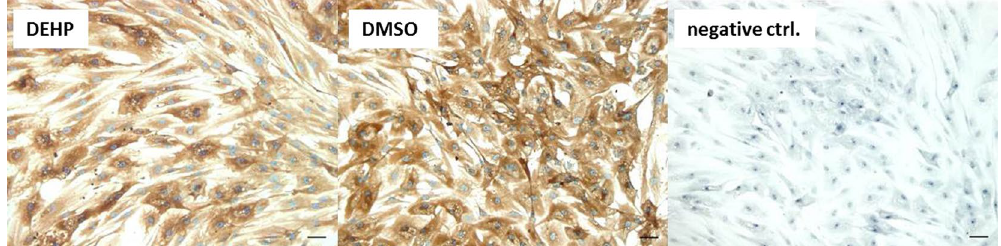
Figure 10. Immunohistochemistry for GLUT4 in SGBS-adipocytes: SGBS cells were exposed to DEHP from d0–d4 and subsequently differentiated into adipocytes. For the analysis of GLUT4 localization within the adipocytes, the cells have been fixed with PFA at d8, stained for GLUT4 (HRP-conjugated antibody – brown staining) and counterstained with hematoxylin (blue staining). The figure shows representative micrographs at × 200 magnification of DEHP treated adipocytes and DMSO controls, as well as the negative control without GLUT4 but secondary antibody. The scale bar indicates 50 µ